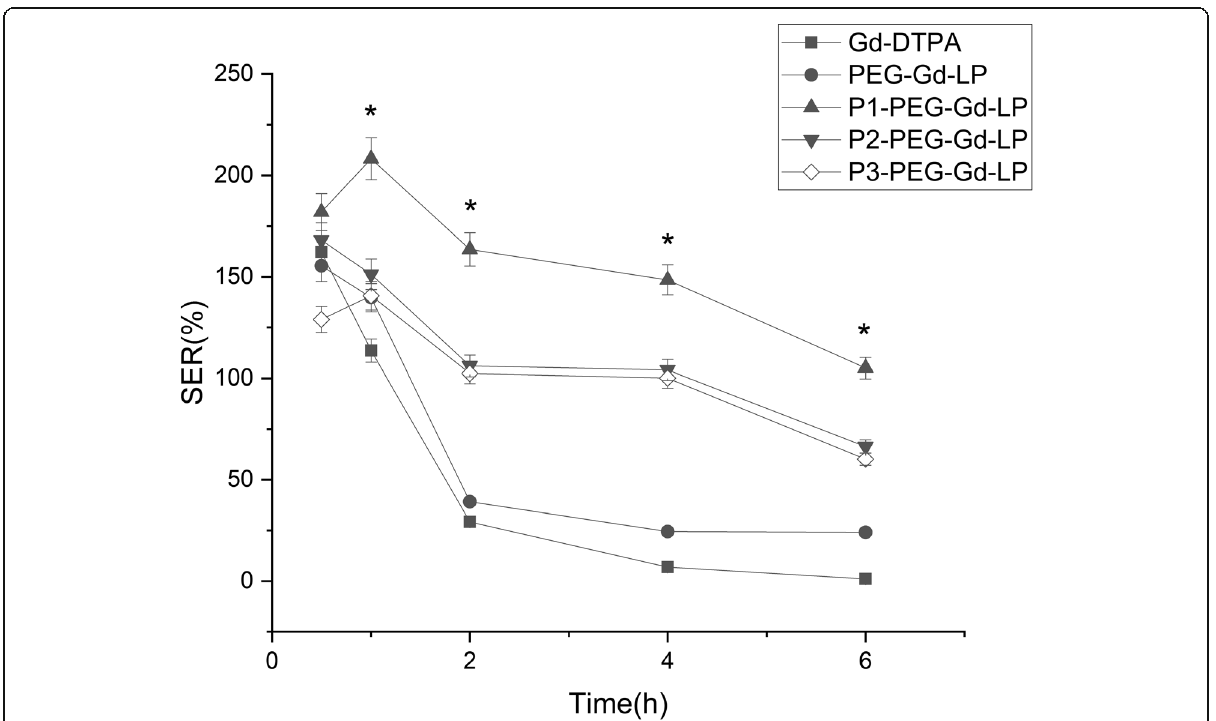
Fig. 4 Determination of SER in different time points with an injection of pure Gd-DTPA, Gd-LP, P1-Gd-LP, P2-Gd-LP, and P3-Gd-LP. N = 3, and * P < 0.05 P1-Gd-LP vs the other four